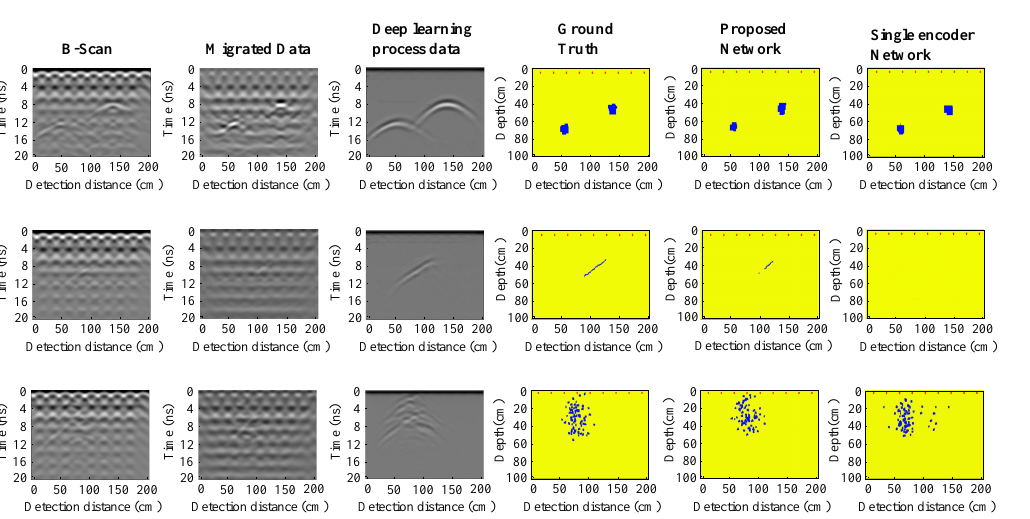
Figure 7. Inversion results on the synthetic dataset: ( a ) synthetic data with void defects; ( b ) synthetic data with cracks; ( c ) synthetic data with untightness. The first three columns depict the original B-scan, migrated, and deep-learning-processed GPR images, respectively, as the input data. The fourth column shows the ground truth permittivity maps. The last two columns depict the inversion results of the proposed method and the single encoder